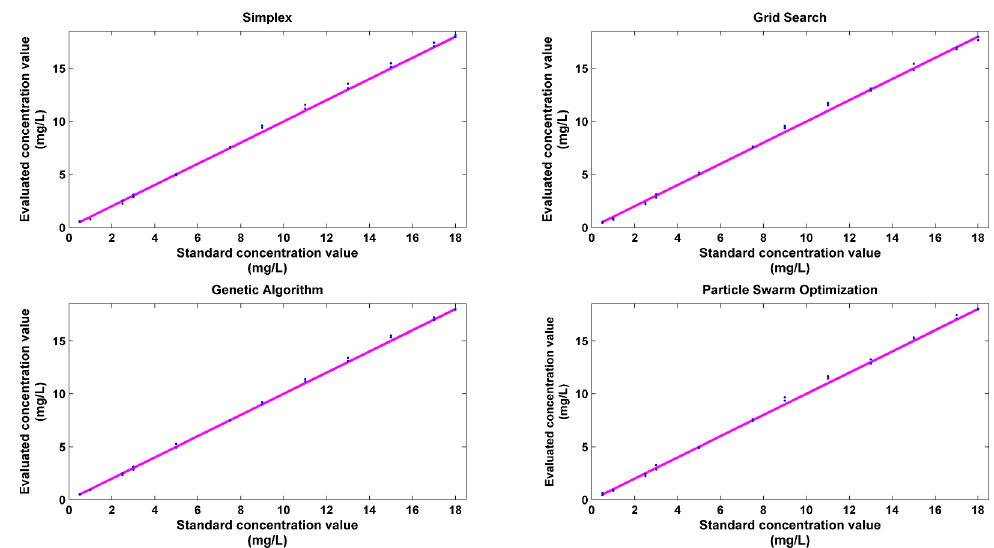
Figure 8. Correlation between standard concentration value and evaluated value modeled by